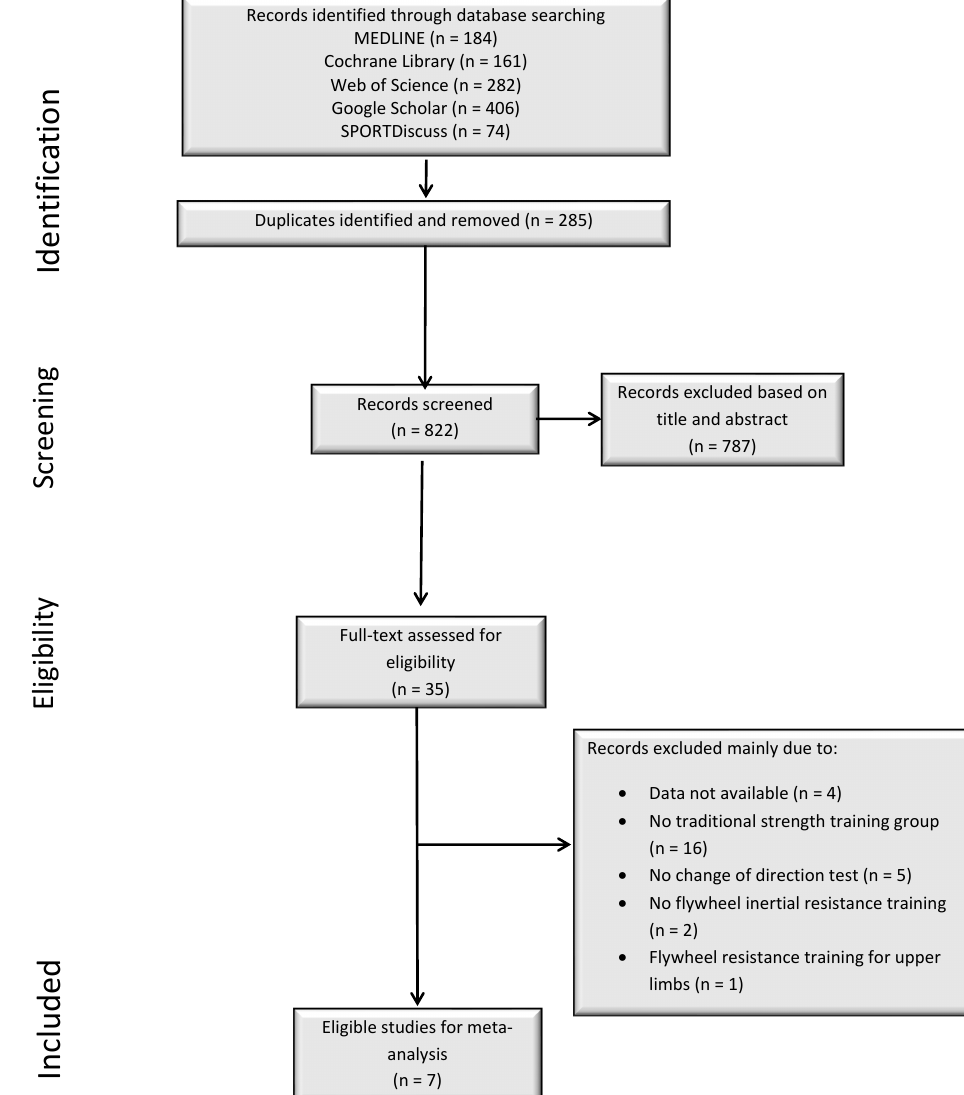
Figure 1. Flow chart illustrating the selection process for all included and excluded